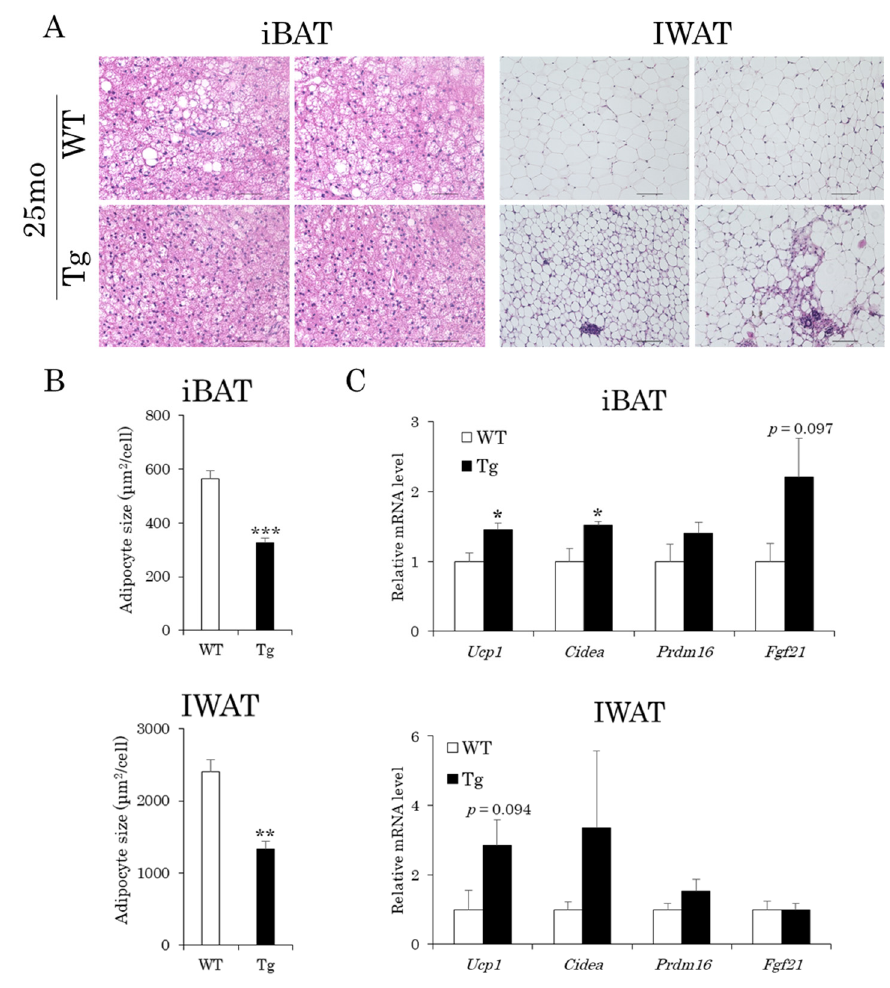
Figure 3. Browning is promoted in the adipose tissue of aged aP2-CREG1-Tg mice. ( A ) Histological analyses of iBAT and IWAT. Representative images of H&E staining are shown. Scale bar: 50 µ m for iBAT, 100 µ m for IWAT. ( B ) Adipocyte size in iBAT and IWAT. ( C ) mRNA expression of brown/beige fat-selective genes ( Ucp1, Cidea, Prdm16: PR domain containing 16, and Fgf21) in iBAT and IWAT. Data are means ± SEM ( n = 4). * p < 0.05, ** p < 0.01, *** p < 0.001 vs. WT.